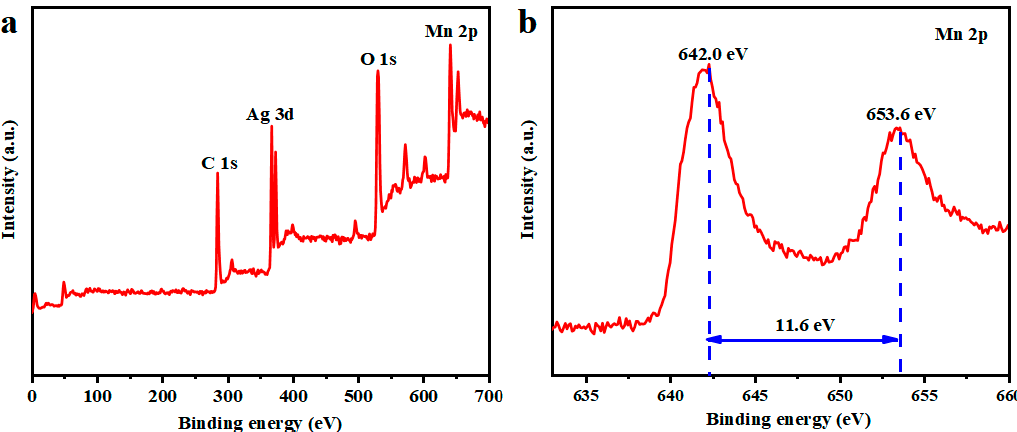
Figure 4. ( a ) Wide-scan XPS spectra of nylon/Ag/MnO 2 ; ( b ) narrow spectra of Mn 2p peaks.